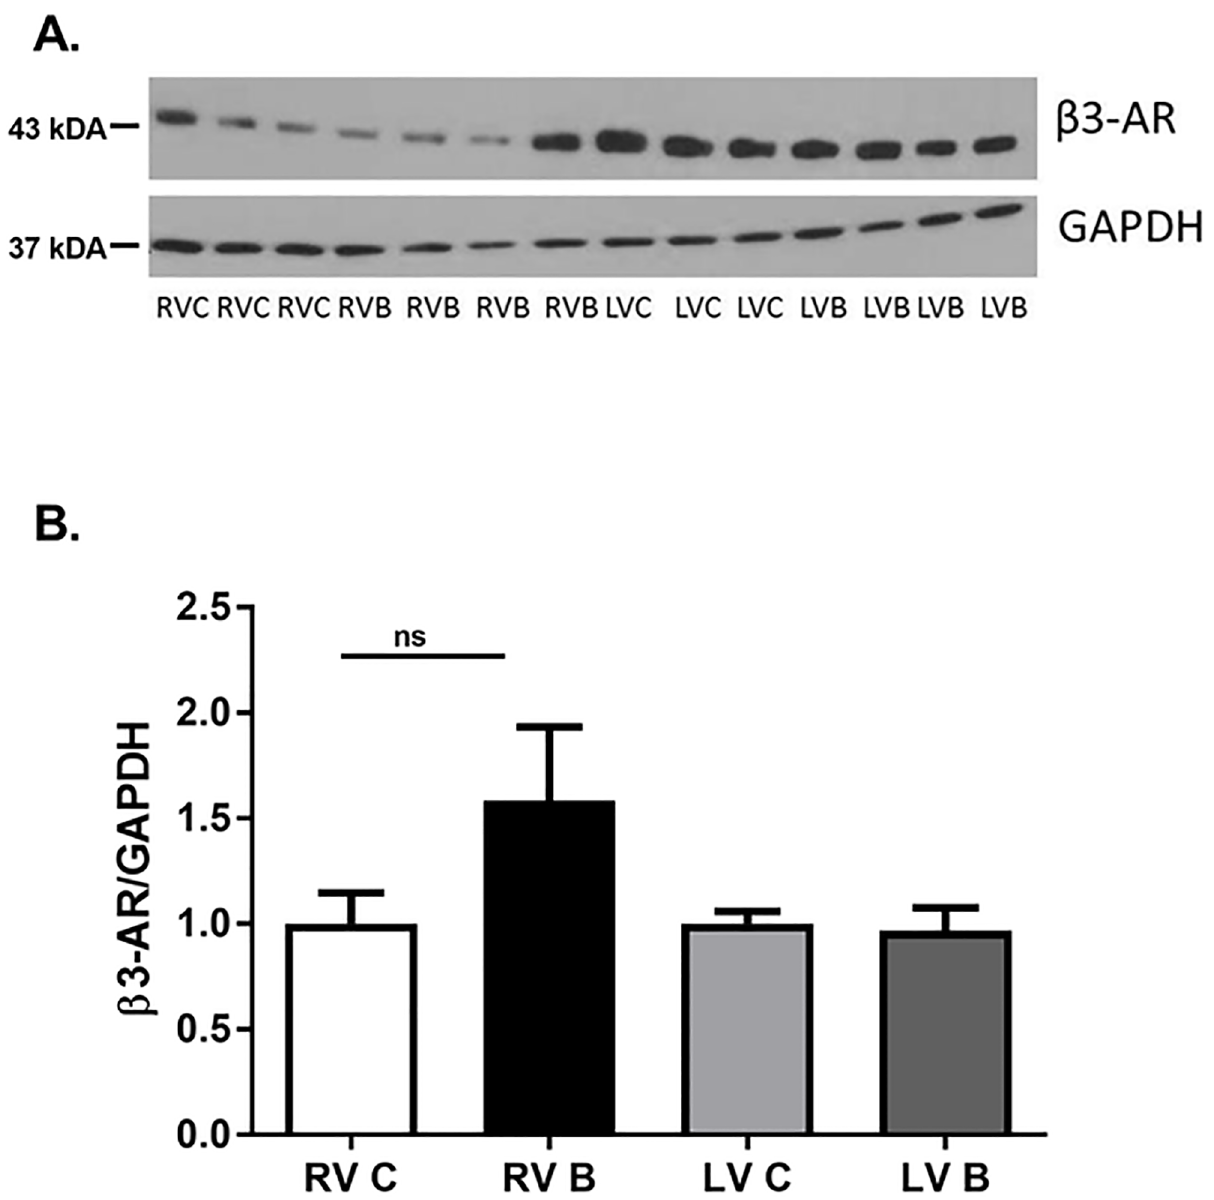
Fig 3. β 3 -AR protein expression post-burn. Representative Western blots of β 3-AR protein expressionin right and left ventriclesseven days post-burn. Controls were nonburnedanimals. The bar graphs show the ratio of protein to GAPDH. Data are expressedas the mean ± SEM. Statistical analysiswas performed using a one-wayANOVA. n = 6; RV C: right ventriclecontrol; RV B: right ventricle burned; LV C: left ventricle control; LV B: left ventricleburned; β -AR; beta adrenergicreceptor.